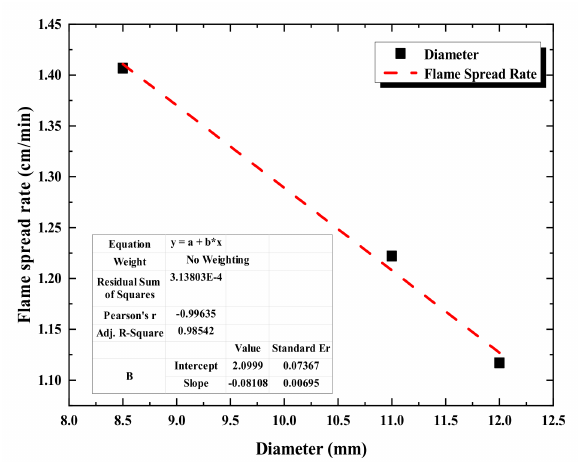
Figure 10. Fitting relationship between the flame-spread rate and diameter of a single cable.